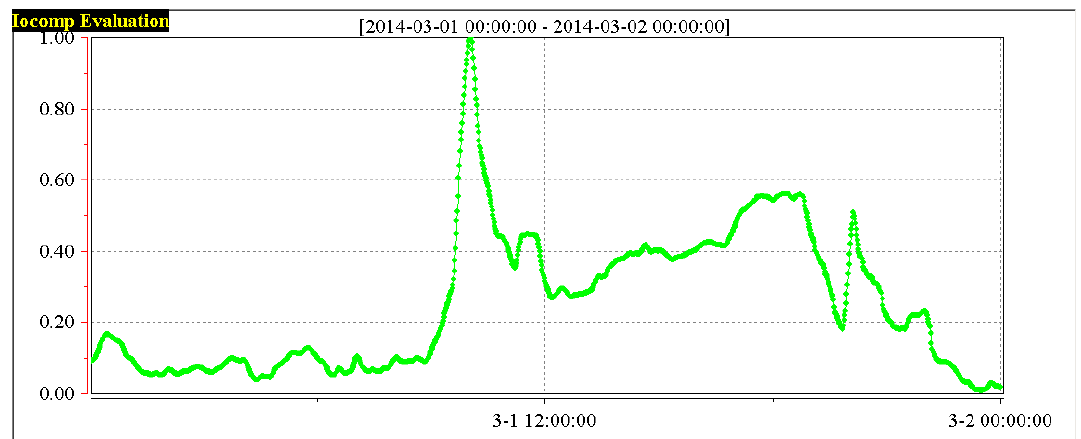
x (%) (2# boiler). x (%) (2# boiler). 1 1